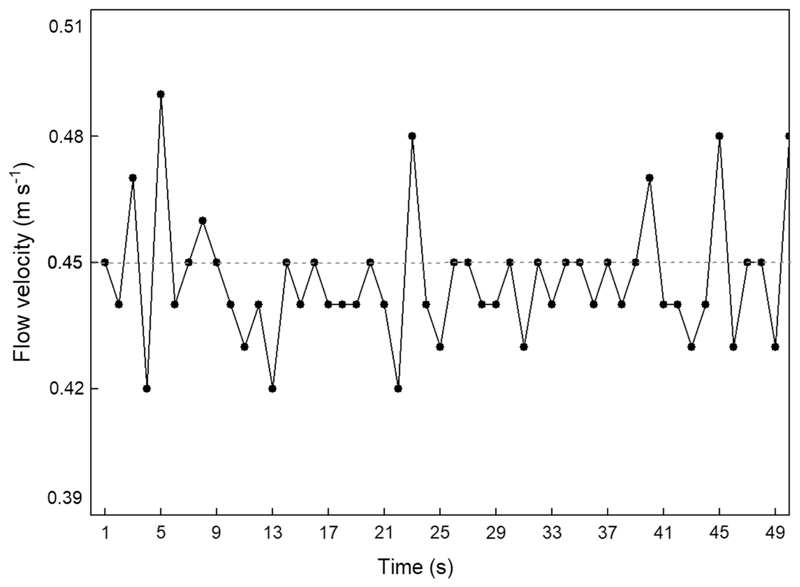
Detail of spatio-temporally filtered velocity measurements (velocity resolution = 0.01 m s−1) over a period of 50 s (time resolution = 1 measurement per s) for larva #7. Mean velocity is indicated by a dashed line